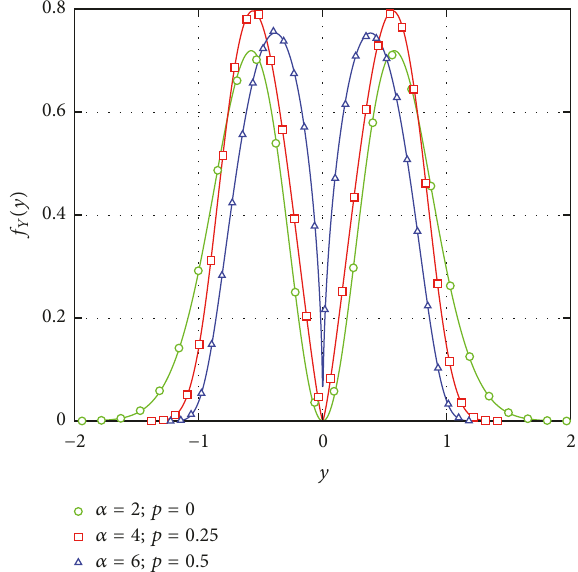
Figure 4: Empirical and theoretical 𝑓 𝑌 (𝑦) distribution with 𝜇 = 3